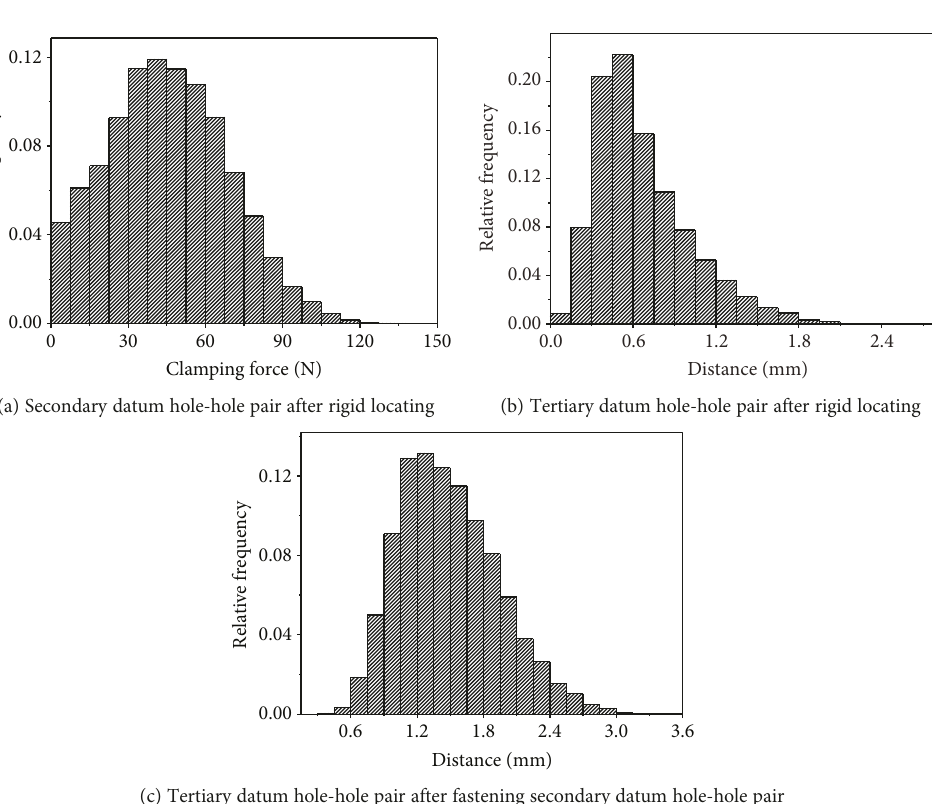
Figure 7: Distributions of distances between nonprincipal datum hole-hole pair centers.